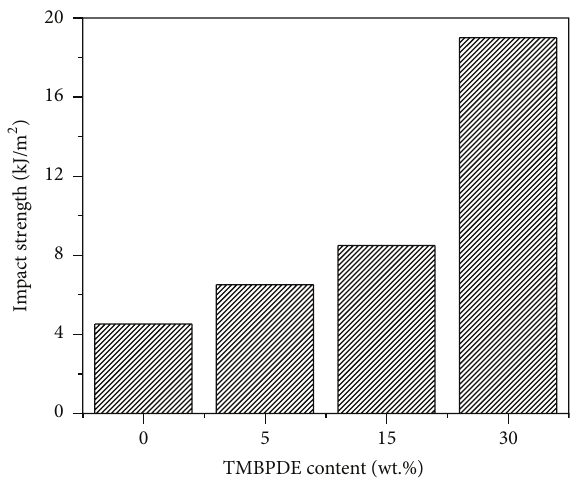
Figure 9: Impact strength of UFUR/TMBPDE composite resins with different TMBPDE